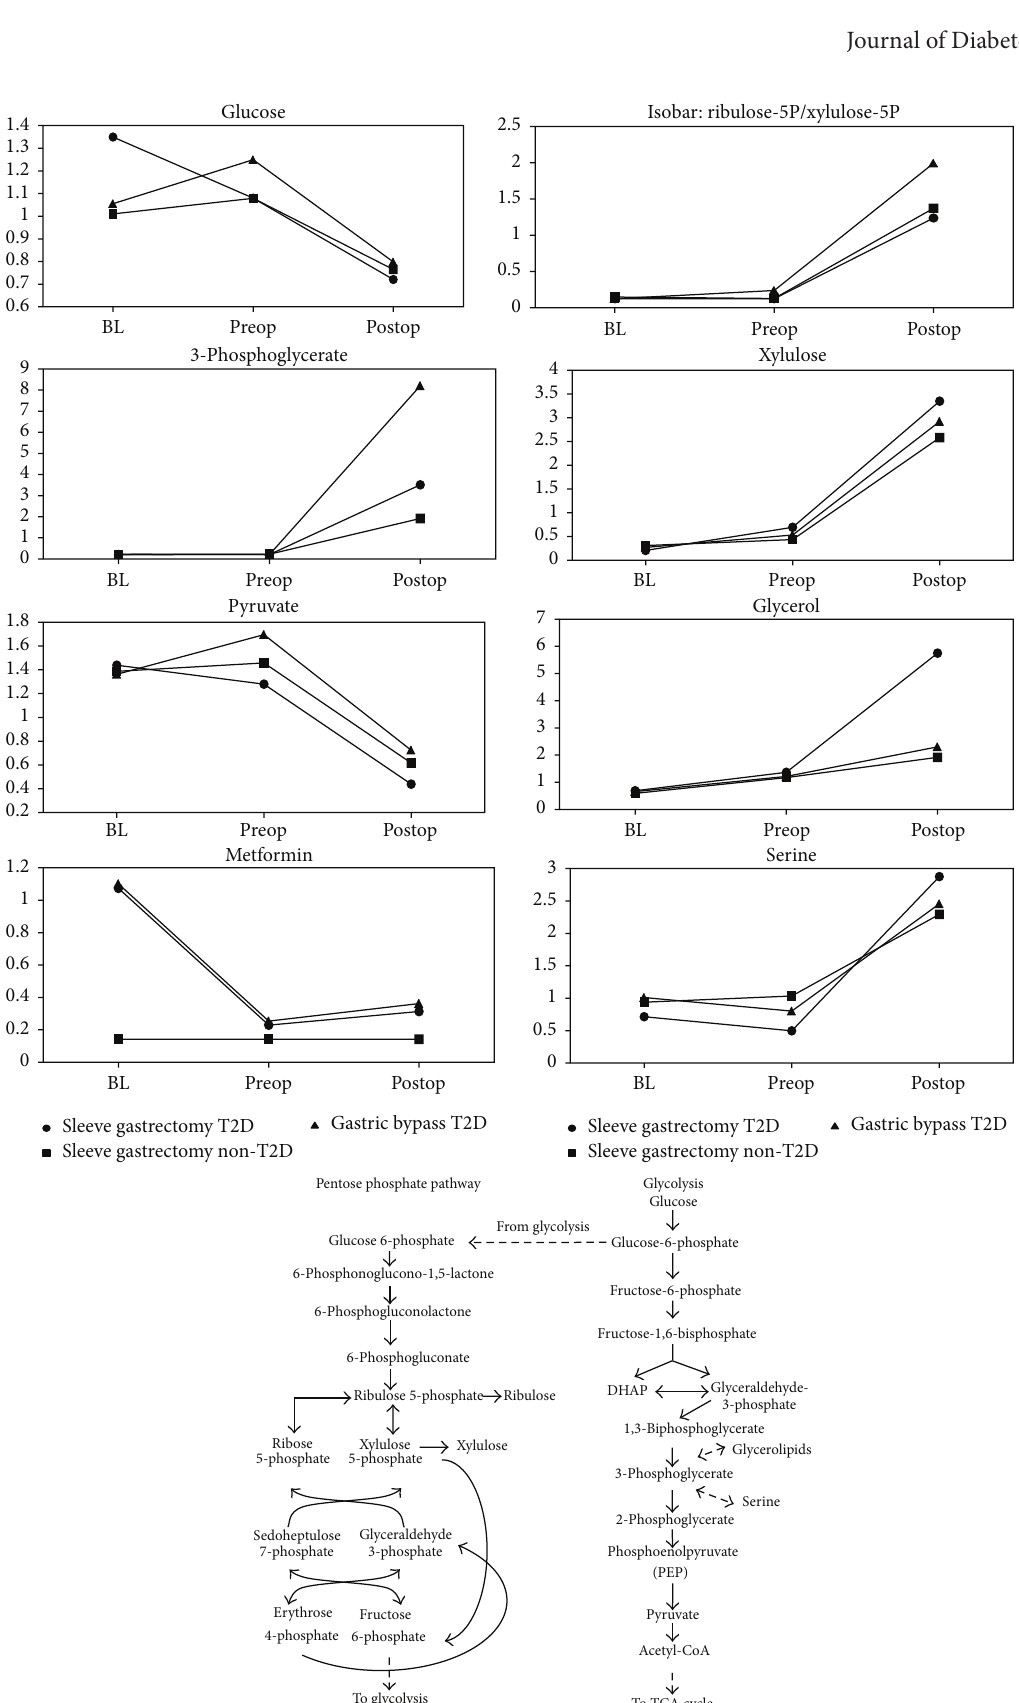
Figure 3: Postsurgery glucose usage shift towards pentose phosphate pathway. All shown metabolites meet the conservative criteria of 𝑃 < 0.05 and an estimated false discovery rate of less than 5% ( 𝑞 < 0.05